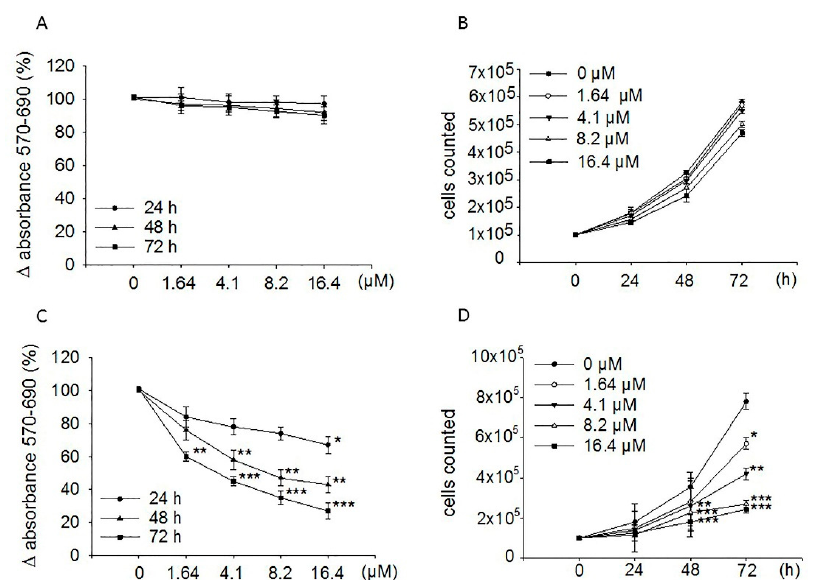
Figure 1. Effects of moringin on the proliferation of WI-38 and SH-SY5Y cells. Both WI-38 ( A and B ) and SH-SY5Y ( C and D ) cells were exposed to the drug (1.64–16.4 µM) for the indicated times. Proliferation rate was performed by the MTT assay ( A and C ) and cell count ( B and D ). MTT results are expressed as percentages ± SEM of absorbance detected in treated cells. Each concentration was eightfold tested, and three independent experiments were carried out. Data from the cell counts were expressed as mean ± SEM of three independent experiments performed in triplicate. * p < 0.05, ** p < 0.01, and *** p < 0.001 vs. control, respectively.